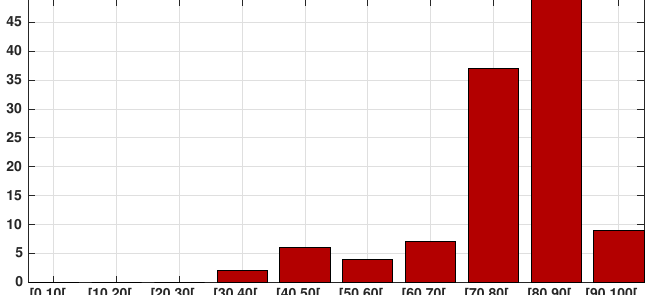
Figure 2. In this figure we plot the number of infected patients for each age class per 10,000 individuals of the same age class (i.e., the number of infected individuals divided by the population of the age class times 10,000). The figure shows that the individuals are more or less likely to becomes infected depending on their age class. The bars describe the susceptibility of people to the SARS-CoV-2 depending on their age class.